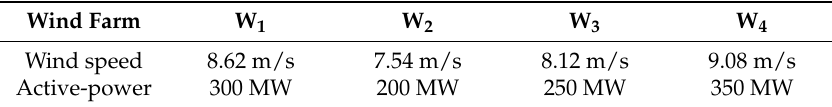
Table 1. Wind speeds and active-power of different